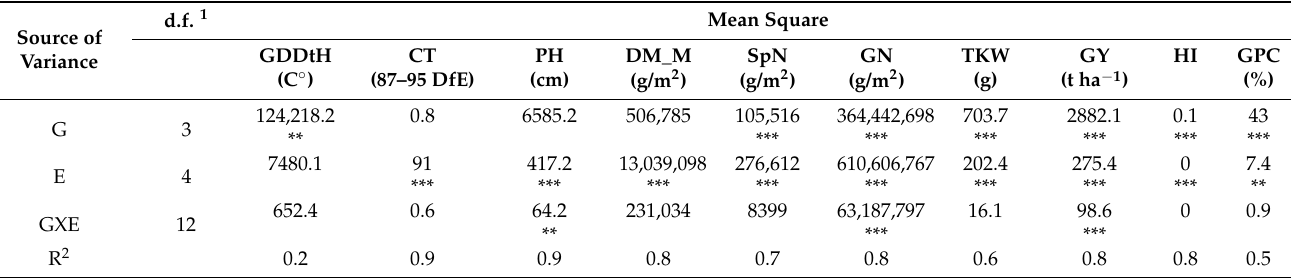
Table 1. Analysis of variance for the effects of genotype group (G), environment (E), and their interactions (GXE) for phenotypic traits: growing degree days to heading (GDDtH), canopy temperature (CT), plant height (PH), grain protein content (GPC), thousand kernel weight (TKW), dry matter during maturation (DM_M), spike number (SpN), grain num- ber (GN), and harvest index (HI).